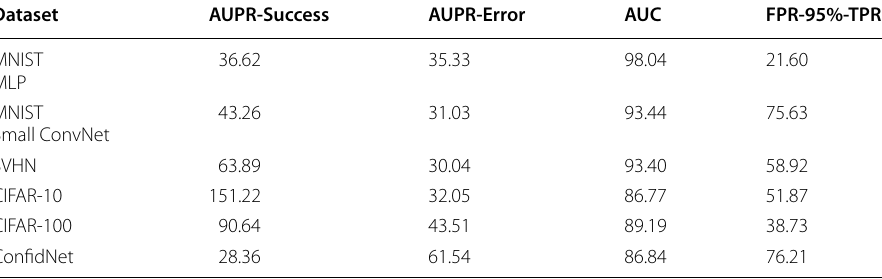
Table 1 Comparison of Failure Prediction Model using Different Datasets